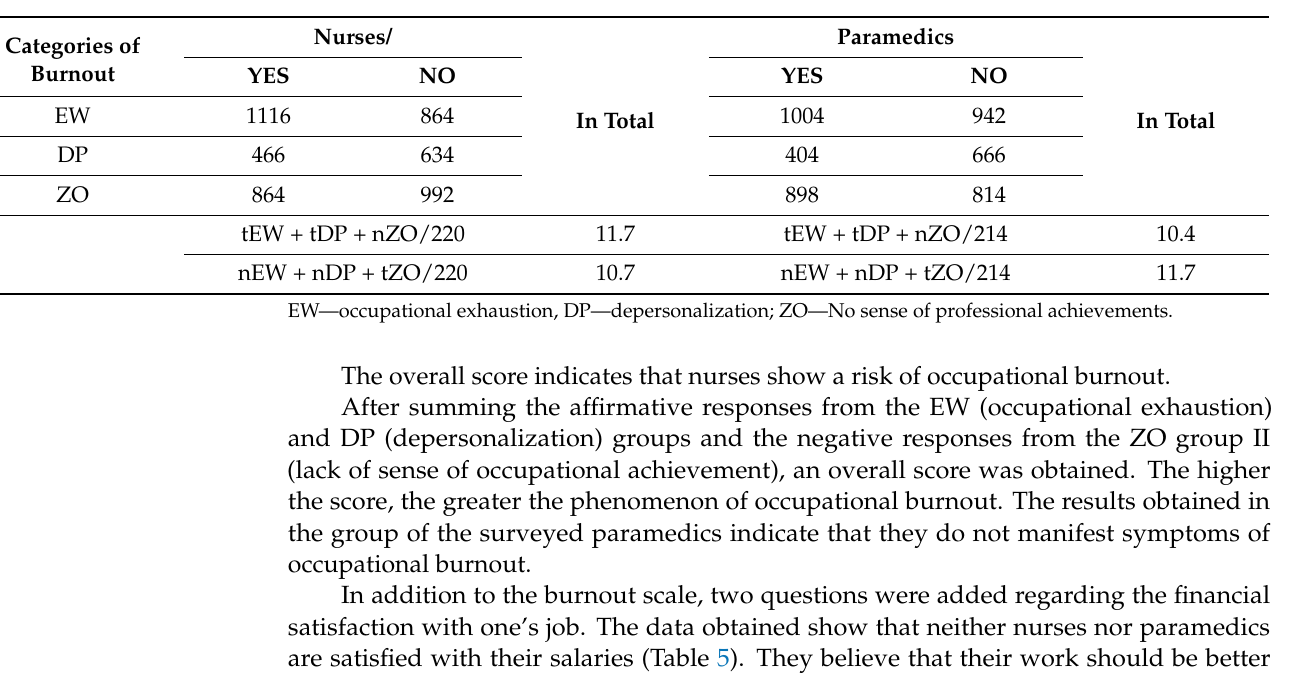
Table 4. Overall scores obtained from the Ch. Maslach burnout questionnaire divided into categories.